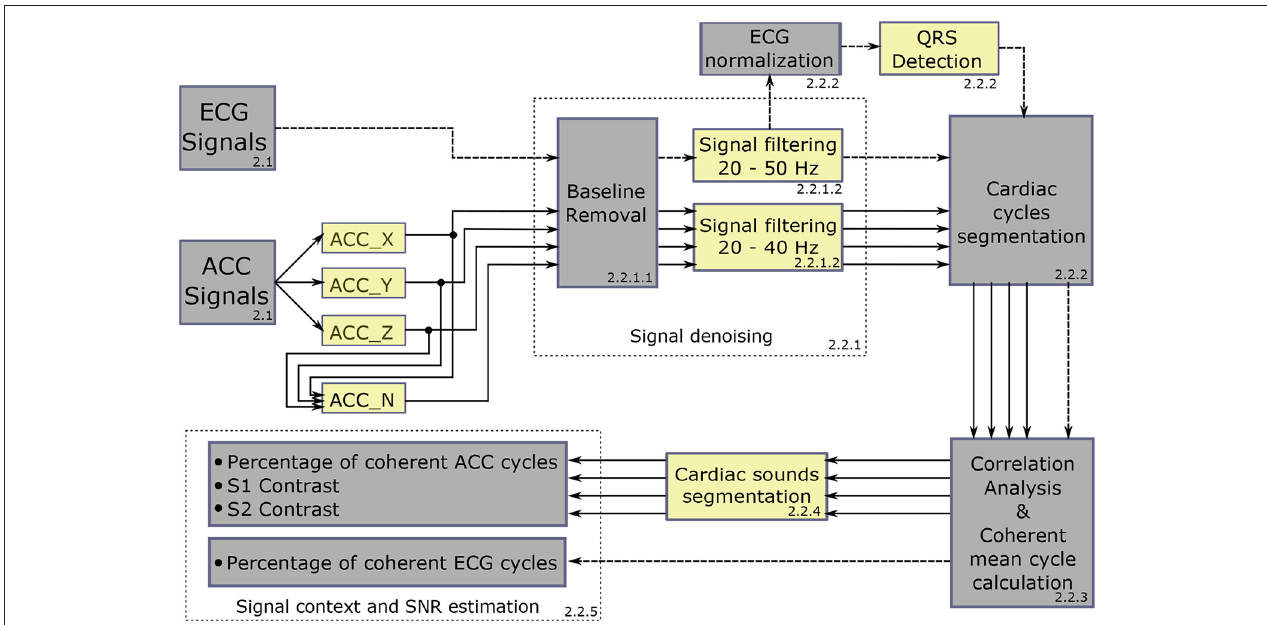
FIGURE 2 | Global diagram of the processing chain applied to the acquired data. Dashed-line arrows represent the ECG signal pipeline and solid-line arrows represent the ACC axes pipeline.